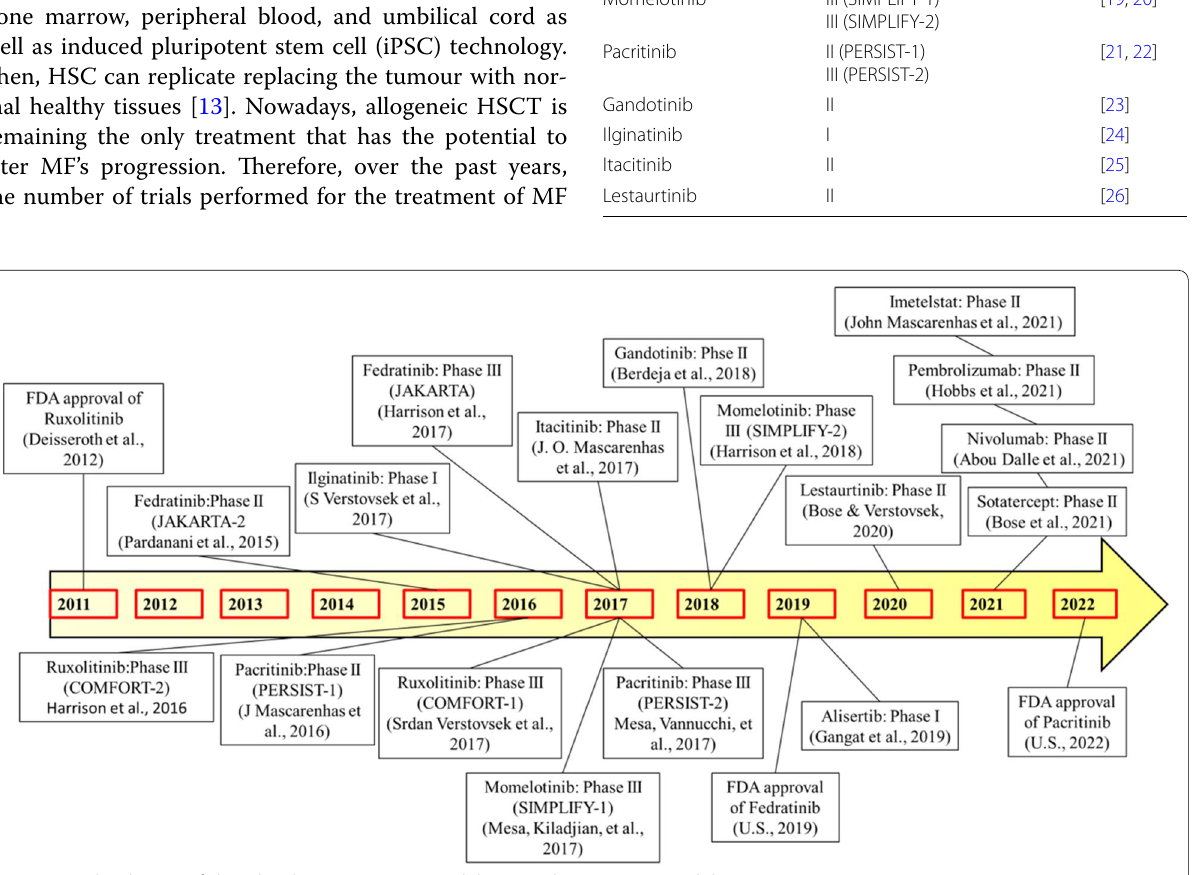
Fig. 1 Timeline history of clinical trials representing JAK inhibitors and non-JAK targeted drugs